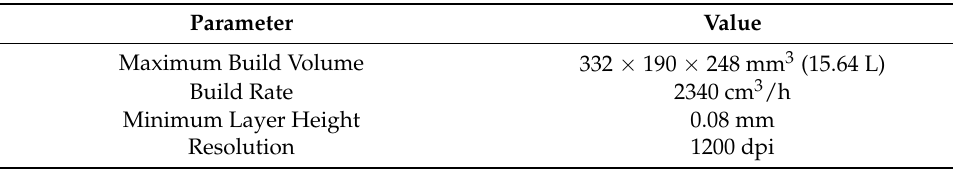
Table 1. Specifications of the HP Jet Fusion 580 Color 3D